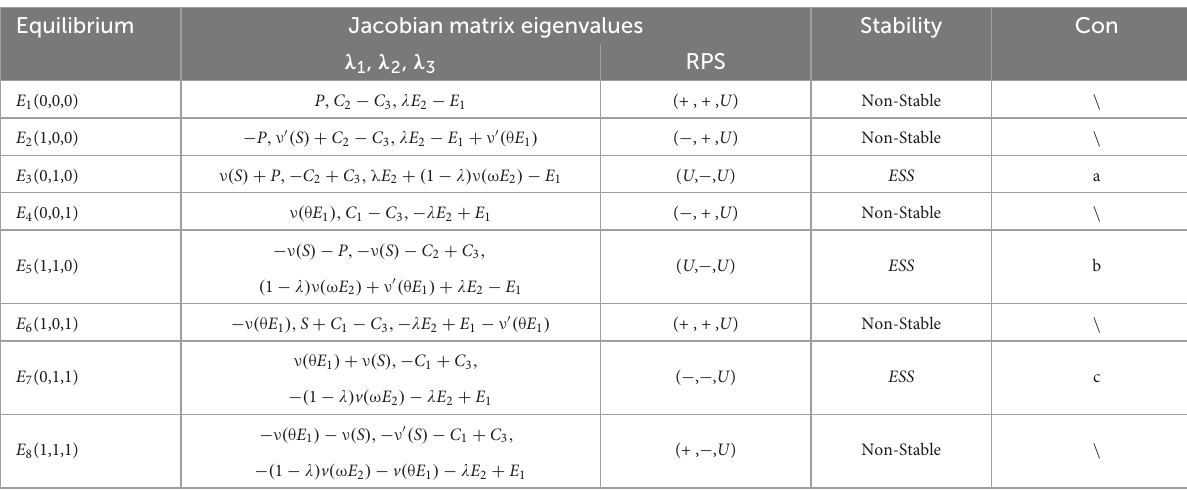
TABLE 2 Stability analysis of equilibria based on Jacobian matrix. Equilibrium Jacobian matrix eigenvalues